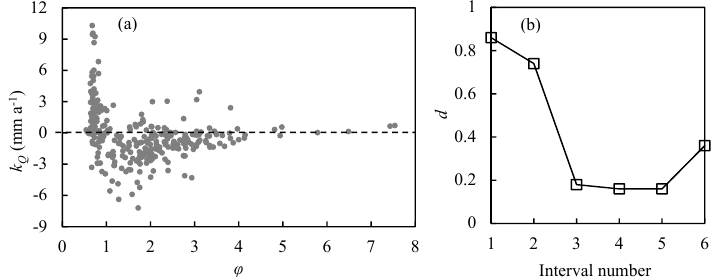
Figure 5. (a) Relationship between observed runoff trends k Q and aridity index ϕ for the study catchments during the period 1956–2000. (b) Values of d in each interval according to ϕ . Interval numbers 1 to 6 correspond to six intervals of 0.5–2/3, 2/3–1, 1–1.5, 1.5–2, 2–3, and 3–8, respectively.